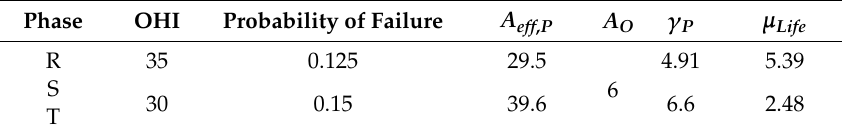
Table 6. Remaining life estimation based on PLN’s failure rate